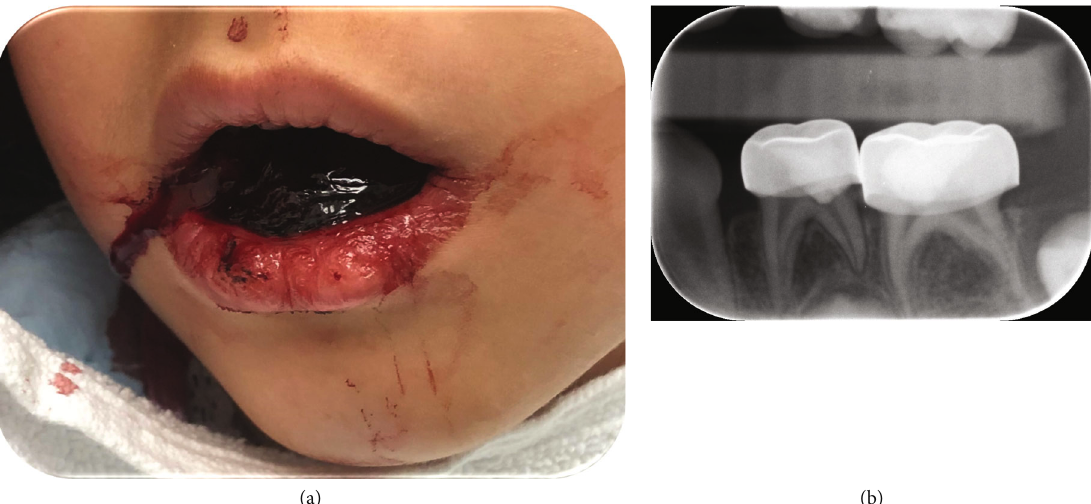
Figure 3: Patient case 5. (a) Excessive bleeding and a blood clot in the mouth of a girl, 16 hours after placing SSCs on her primary lower left fi rst and second molars. (b) A periapical radiograph taken 1-day postoperatively reveals no pathology that may contribute to the excessive